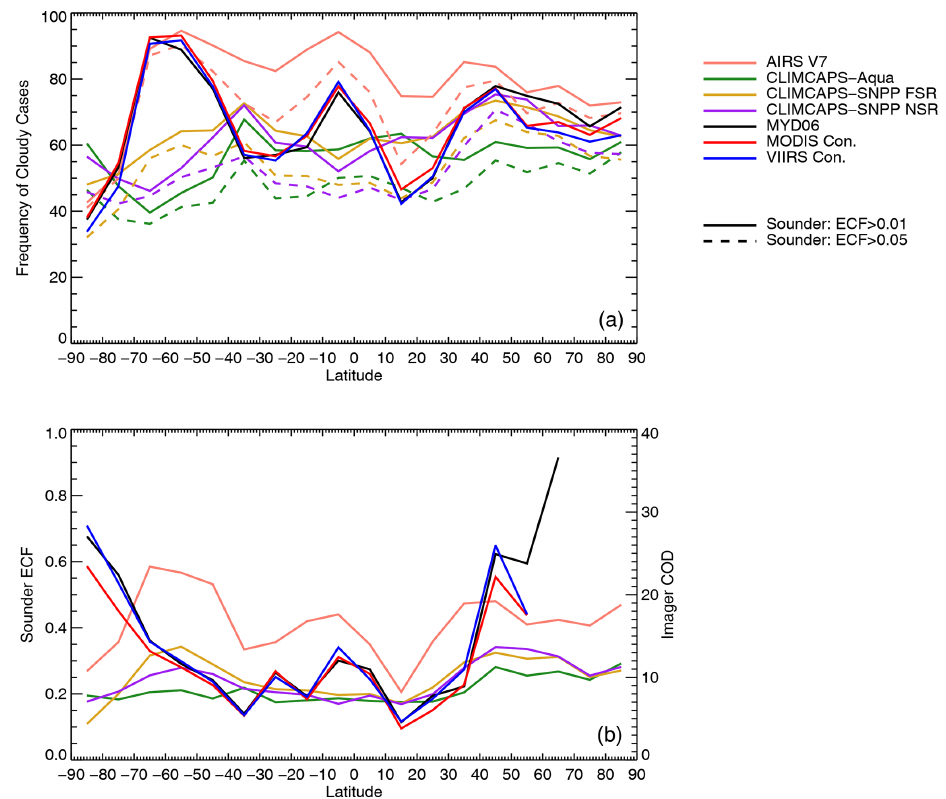
Figure 2. (a) Zonal-mean frequency of cloudy cases as observed by hyperspectral sounders and imagers. For MODIS and VIIRS, frequency of cloudy and uncertain cases as reported by cloud mask is shown for MYD06 (black), MODIS continuity (red), and VIIRS continuity (blue) cloud products. For AIRS and CrIS, solid and dashed lines show frequencies of sounder FOVs with ECF > 0 . 01 and ECF > 0 . 05, respectively. Results for AIRS version 7 (AIRS V7, pink), CLIMCAPS-Aqua (green), CLIMCAPS-SNPP FSR (yellow), and CLIMCAPS- SNPP NSR (purple) are shown for sounder cloud products. (b) Zonal-mean values of sounder ECFs (left y axis) and imager COD (right y axis) from these retrieval